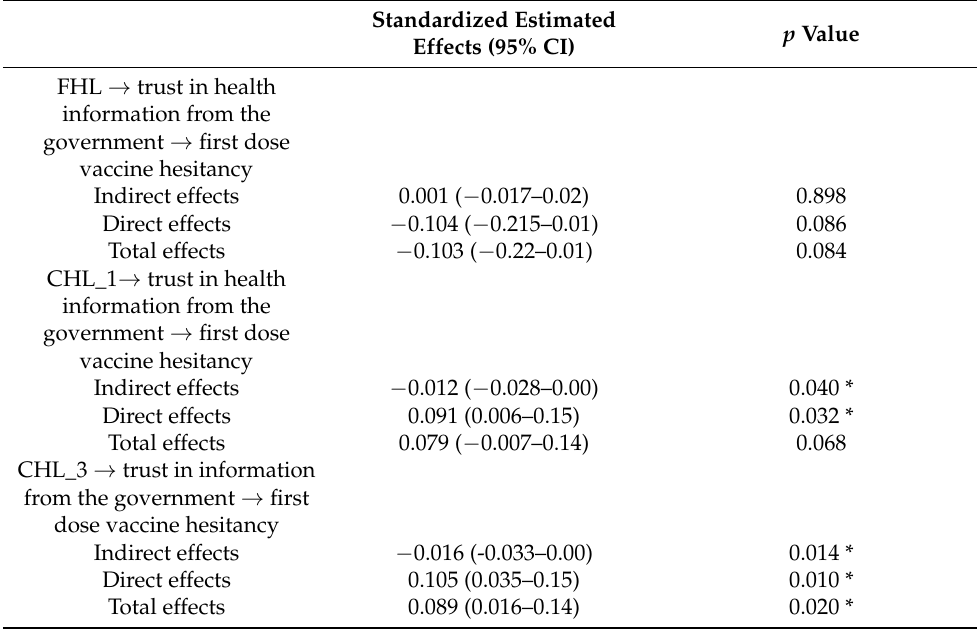
Table 4. Standardized direct, indirect, and total effects for the mediation model a